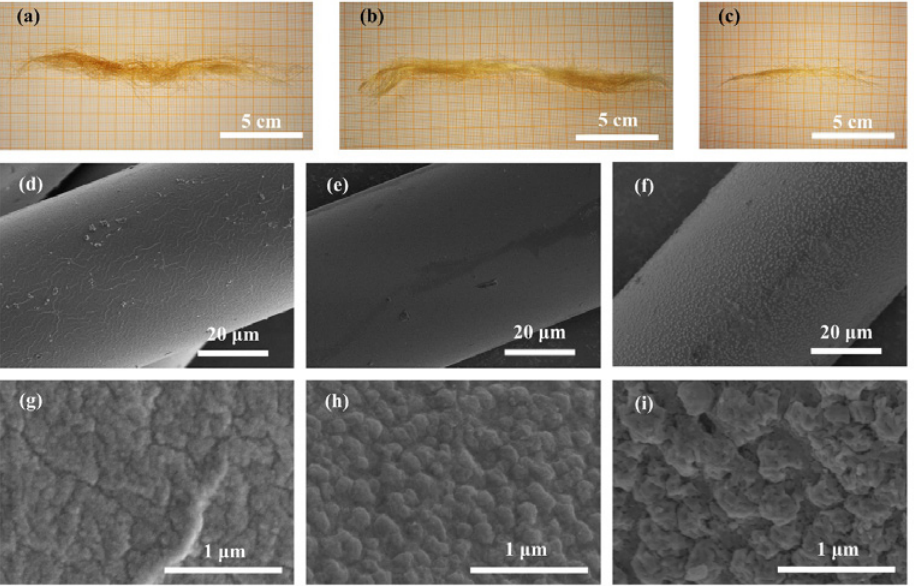
Fig. 4 Optical photos and SEM images of pretreated precursor fibers: (a, d, g) PAWVT-135, (b, e, h) PAWVT-145, and (c, f, i)